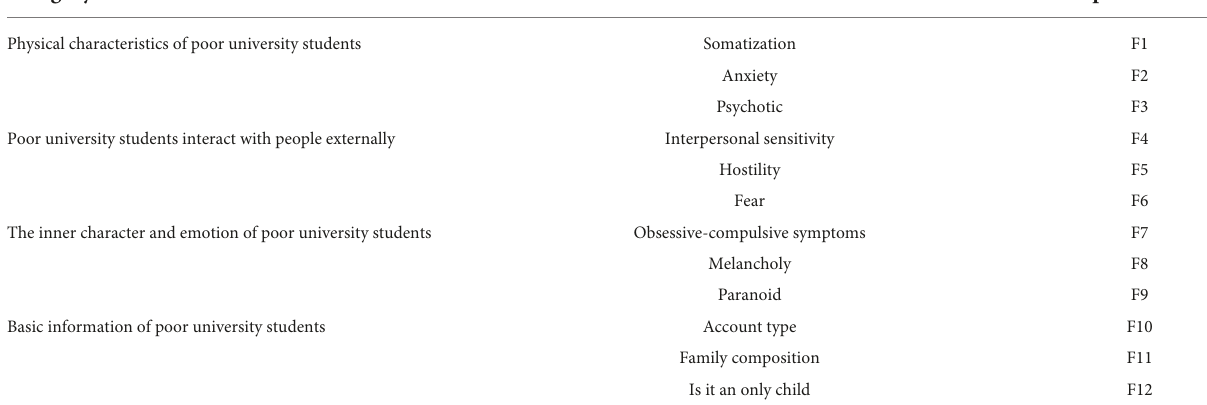
TABLE 3 Factor set representation.